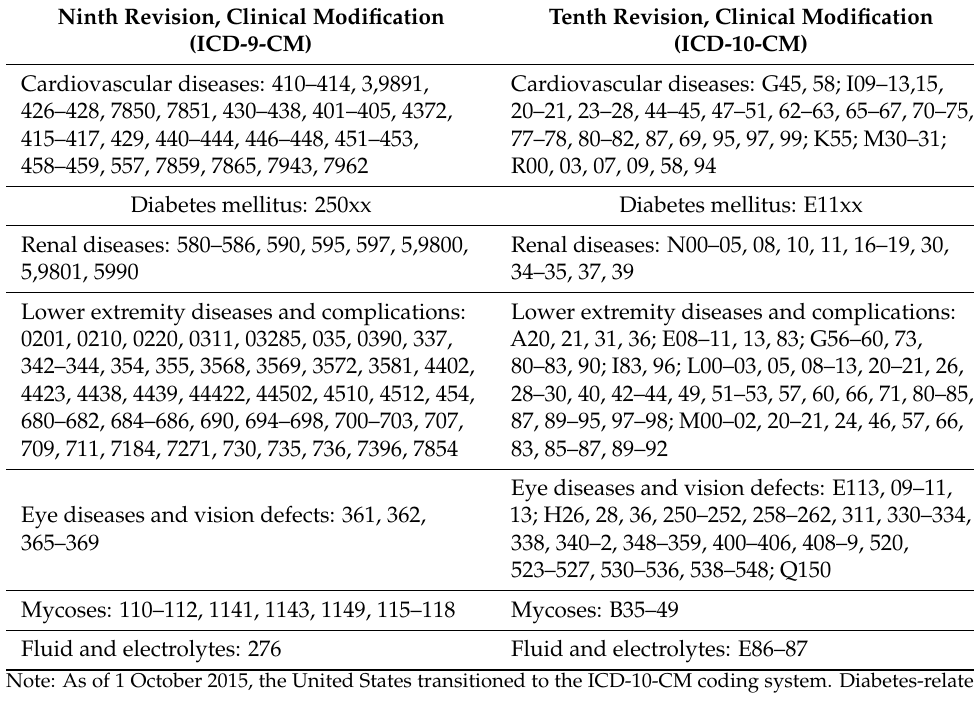
Table 1. International Classification of Diseases (ICD) Codes Used to Identify Diabetes-Related Hospitalizations.